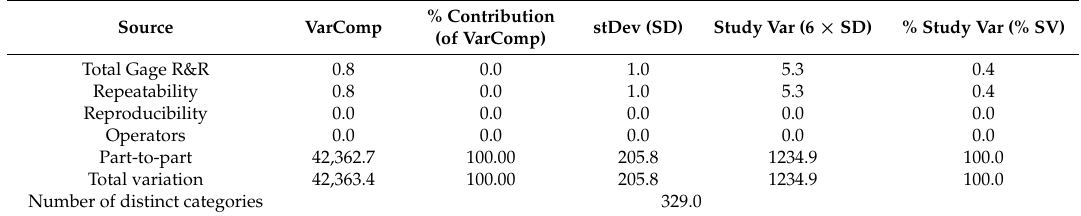
Figure 3. Gage repeatability and reproducibility (R&R) of ( a ) the resonant frequency ( f r ) and ( b ) the quality (Q ) factor for condition 1. Table 3. Condition 1 Gage R&R for resonant frequency ( f r )